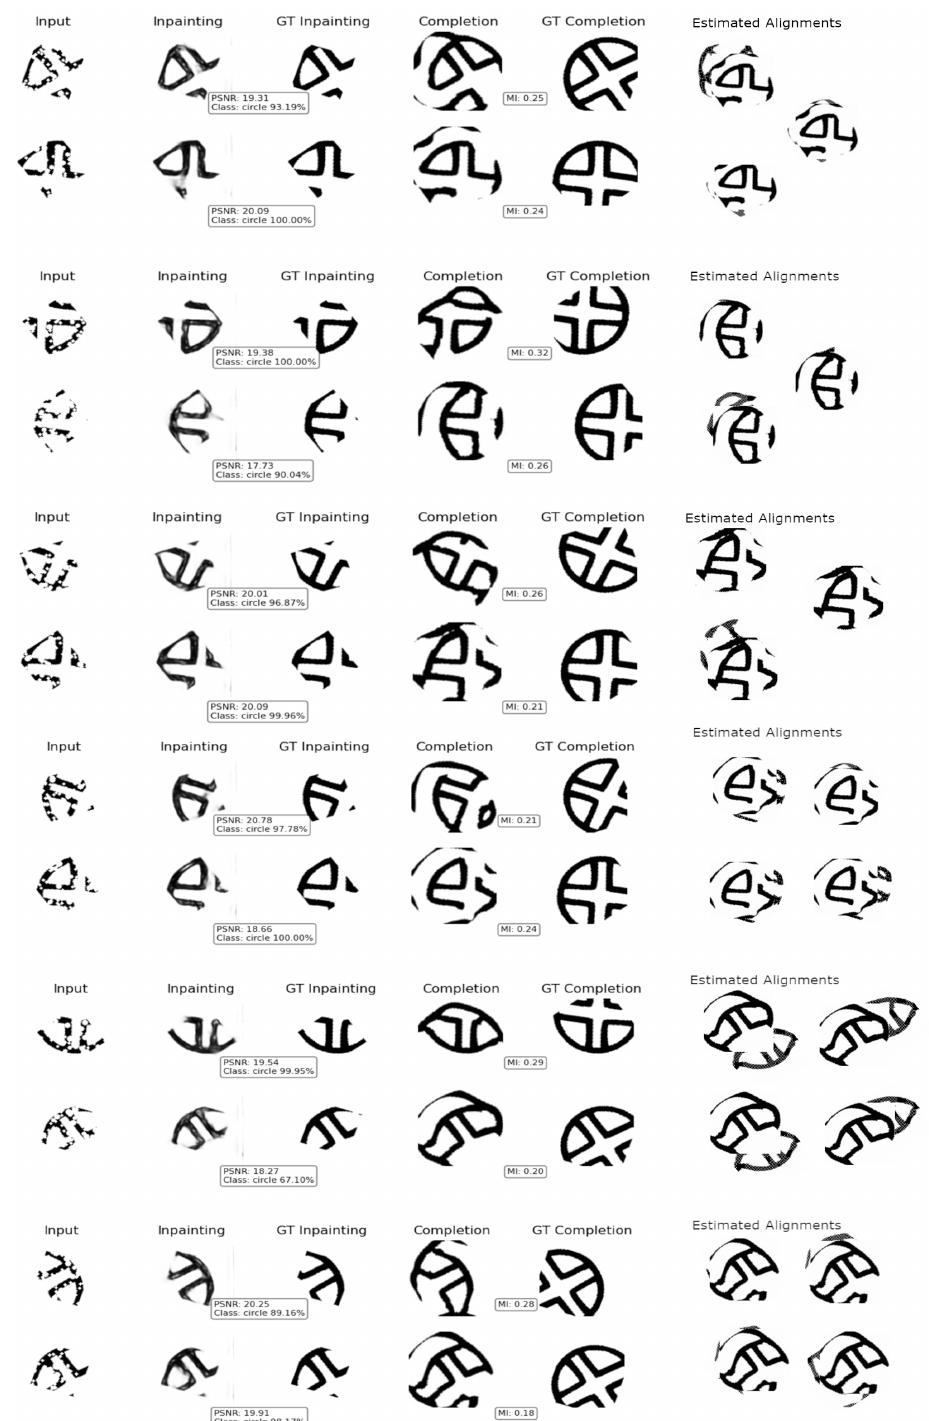
Figure 18. Examples of obtained results for the circle sign. From inpainting to